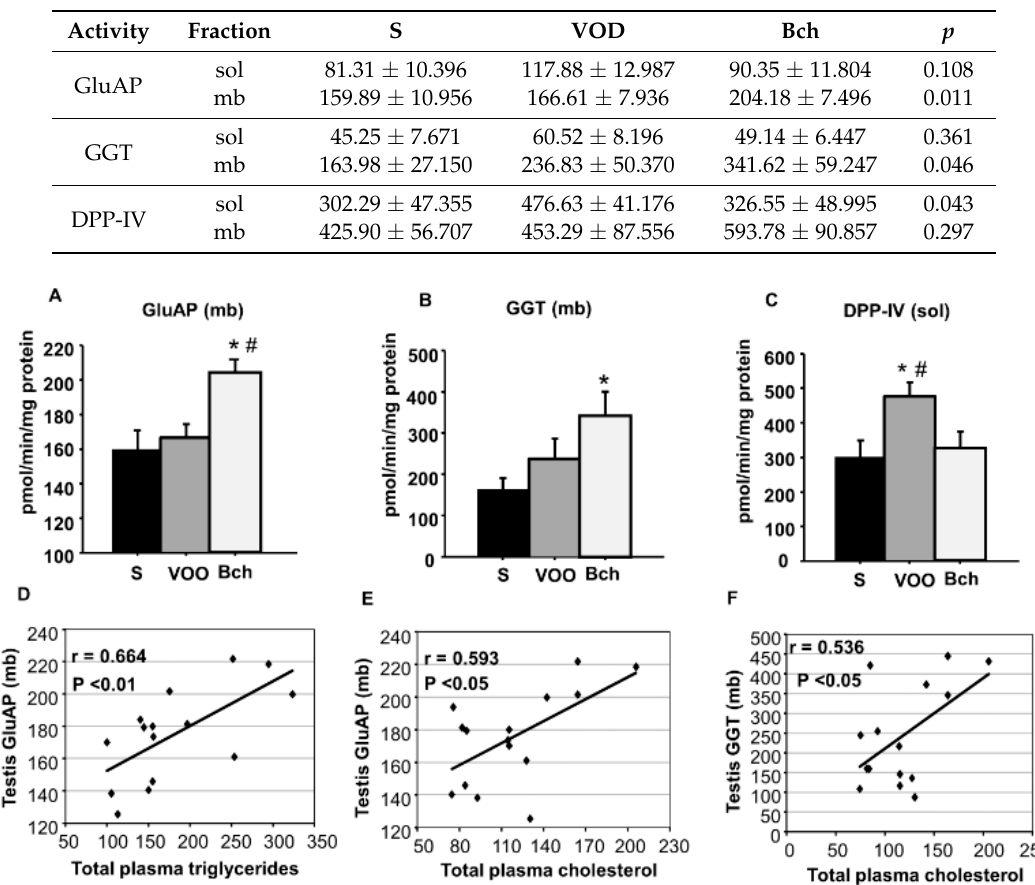
Table 1. Values represent mean ± SEM levels of enzymatic activities, in soluble (sol) and membrane-bound (mb) fractions. Values are expressed as pmol of the corresponding aminoacyl- β -naphylamide hydrolyzed per minute and per mg of protein in the sample. GluAP: glutamyl aminopeptidase; GGT: gamma-glutamyl transpeptidase; DPP-IV: dipeptidyl peptidase IV; S: standard chow diet; VOO: 20% virgin olive oil diet; Bch: 20% butter plus 1% cholesterol diet.